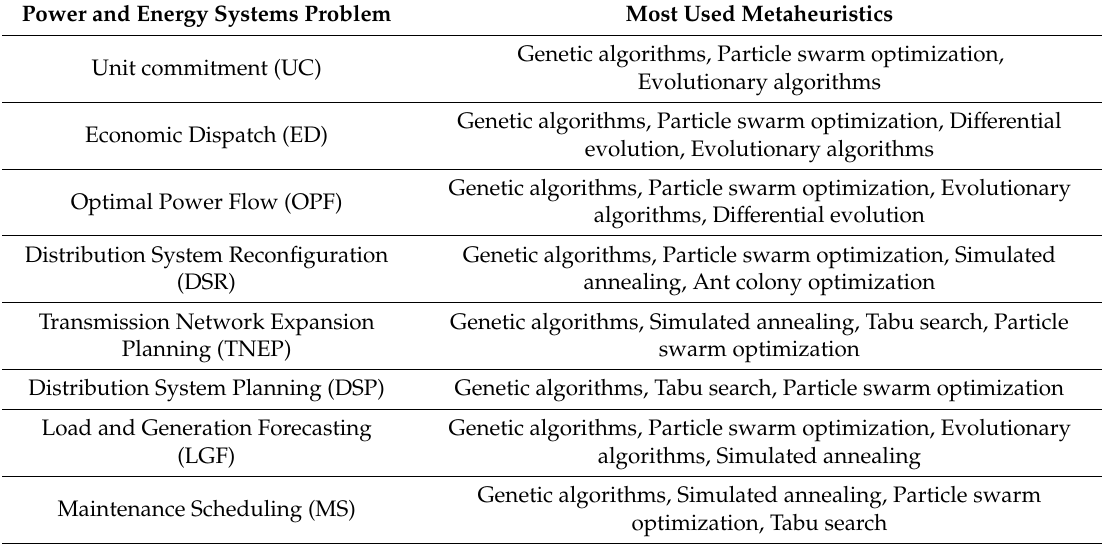
Table 1. Most used metaheuristic algorithms used to solve some power and energy systems problems